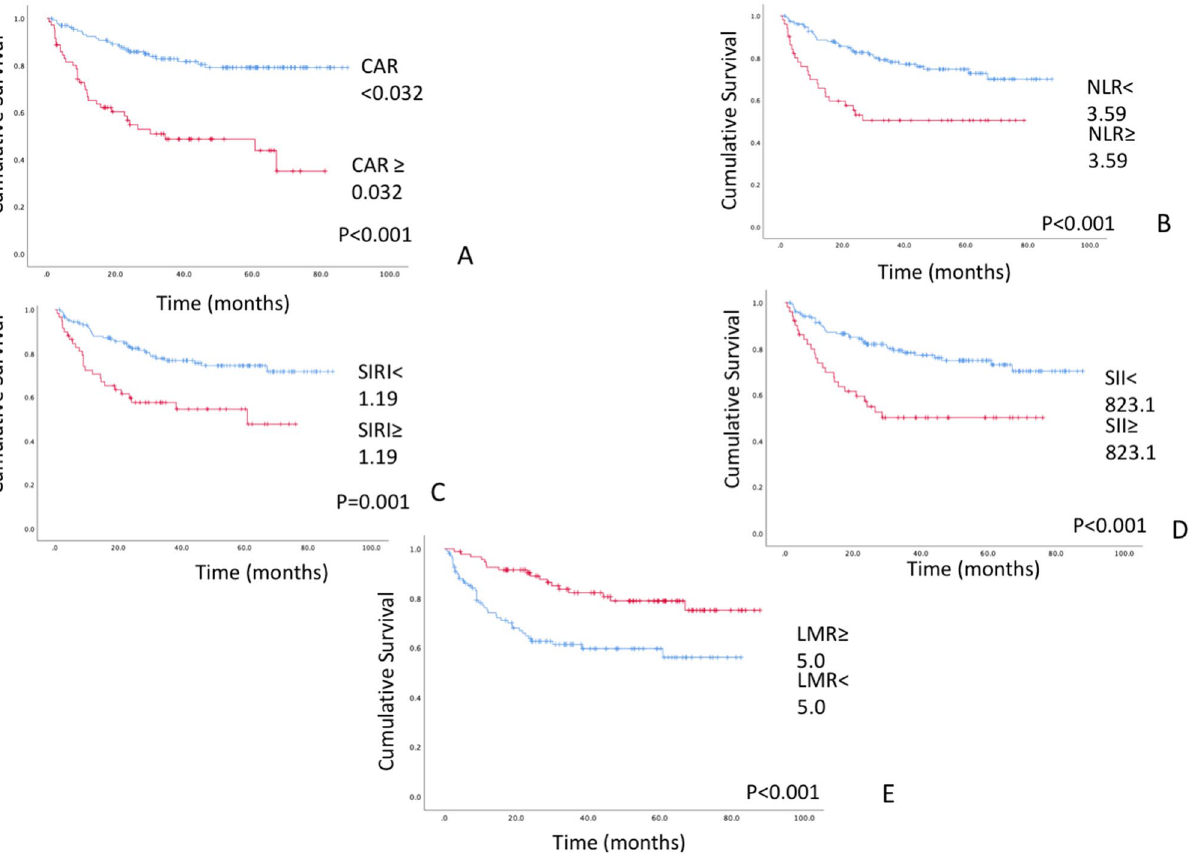
Figure 2. ( A ) Kaplan–Meier survival curve according to CAR. Patients were stratified according to the cutoff value of CAR (0.032). The OS rate was 79.1% for patients with a low CAR (< 0.032) and 35% for a high CAR (≥ 0.032) ( P < 0.001). ( B )–( E ) Kaplan–Meier survival curves according to NLR, SIRI, SII, and LMR. Significant differences in OS were noted when the patient cohort was subdivided into two groups according to the cutoff value of each inflammatory marker (NLR < 3.59, 70.0% vs. NLR ≥ 3.59, 50.4%, P < 0.001; SIRI < 1.19, 71.7% vs. SIRI ≥ 1.19, 47.7%, P = 0.001; SII < 823.1, 70.3% vs. SII ≥ 823.1, 50.1%, P < 0.001; and LMR ≥ 5.0, 75.2% vs. LMR < 5.0, 56.1%, P < 0.001). A less favorable prognosis was associated with a higher NLR, SIRI, and SII values and a lower LMR